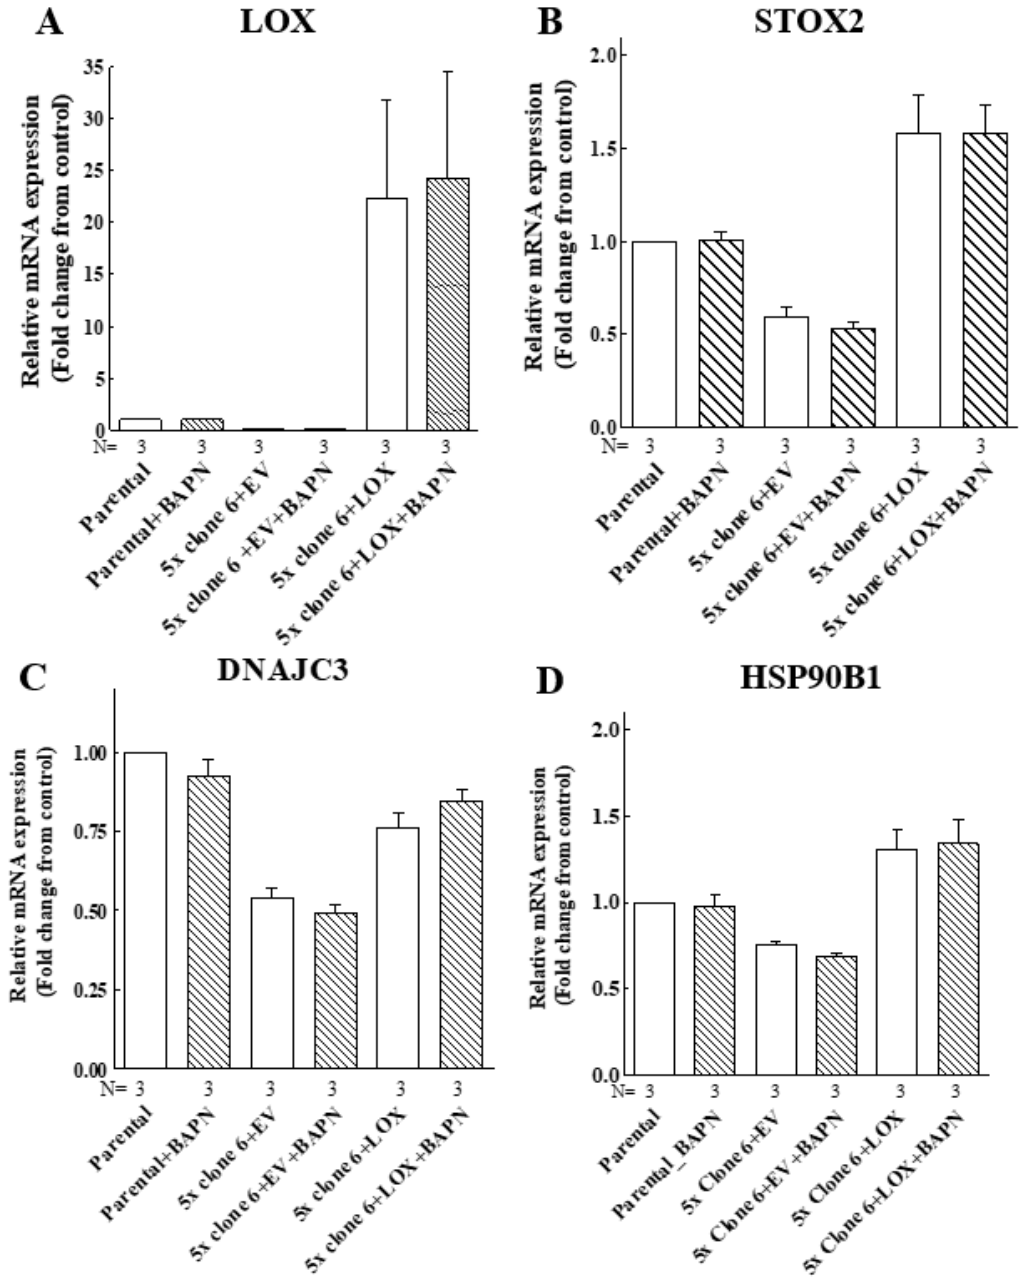
Figure 9. The LOX-induced expression of the STOX2, DNAJC3 and HSP90B1 genes does not re- quire LOX enzyme activity. Parental MB-MDA-231 cells (parental), clone 6 5× knock-out cells in- fected with empty lentiviruses (5x clone 6 + EV) or clone 6 x5 knock-out cells expressing the LOX cDNA (5× clone 6 + LOX) were cultured in the absence or presence of 250 μM BAPN and 5 μM CuSO 4 for 48 h. Subsequently, the mRNA expression of LOX ( A ), STOX2 ( B ), DNAJC3 ( C ) and HSP90B1 ( D ) was examined using qRT-PCR. Results were normalized with the expression level in MB-MDA-231 parental cells in each of the experiments. Data represent the mean ± SEM of N in- dependent experiments.